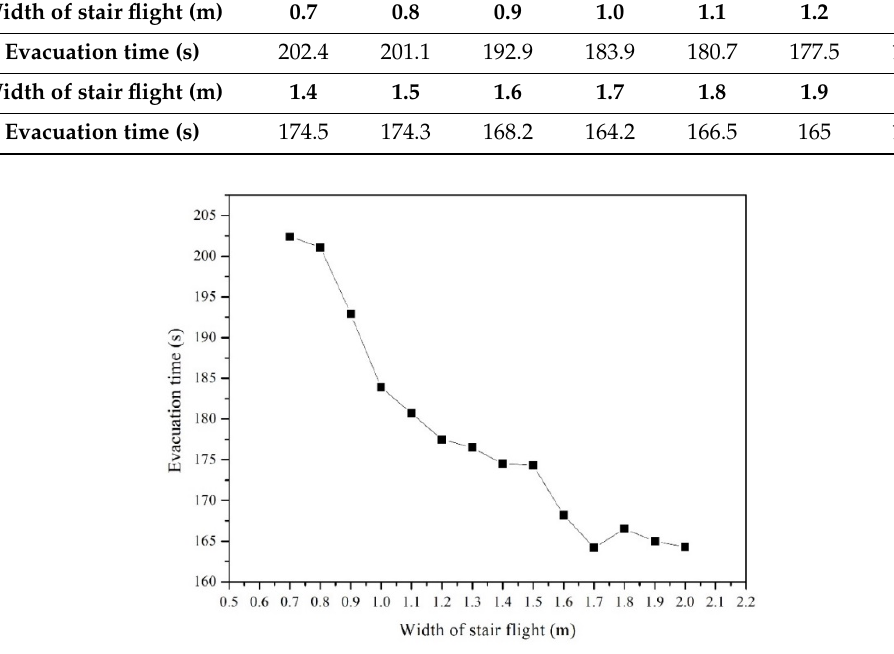
Figure 7. Relationship between the width of stair flight and evacuation time.